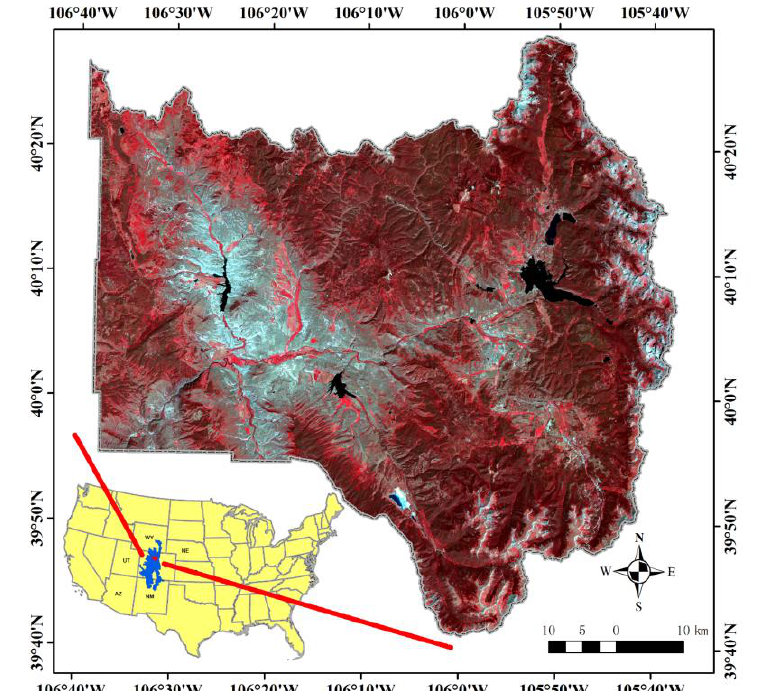
Figure 1 . The study area used for our analyses. The Southern Rocky Mountain ecoregion is shown in blue, and Grand County, Colorado, USA, is shown in red. The imagery is a false-color composite of one Landsat image acquired on 21 August